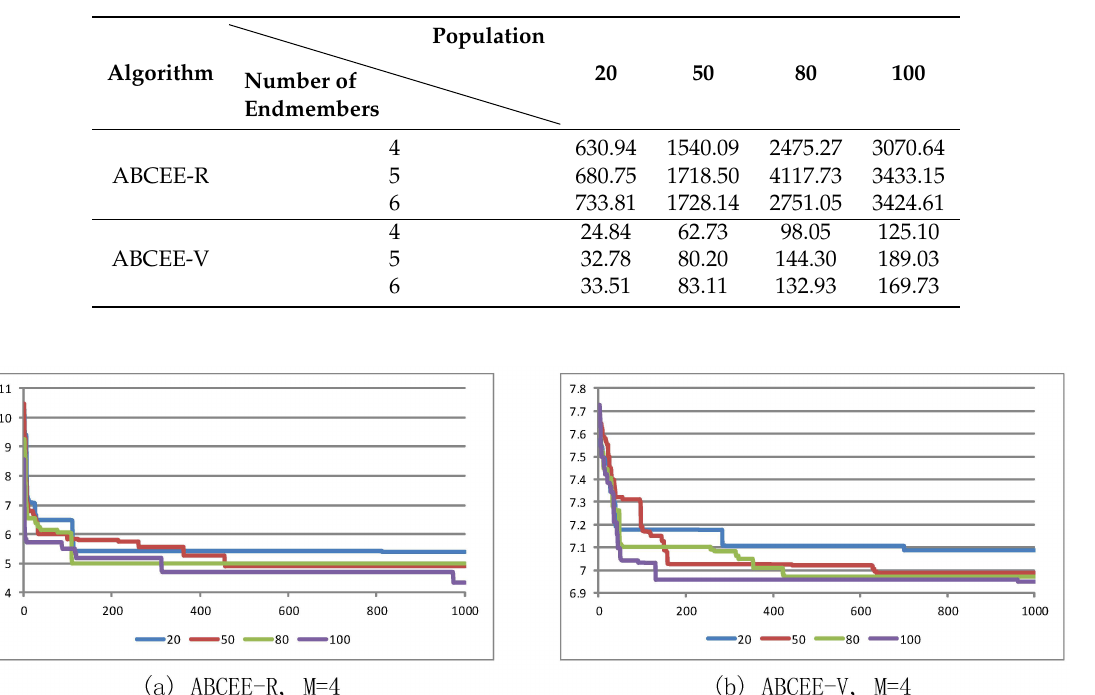
Table 2. ABCEE computation time comparison for different populations (seconds).